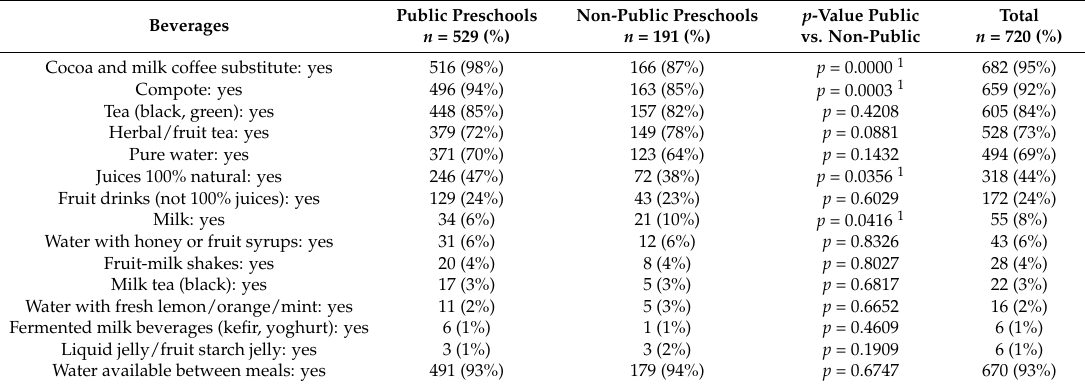
Table 3. Beverages offered with meals to children in participating preschools: comparison of public and non-public institution, and data for the total group.